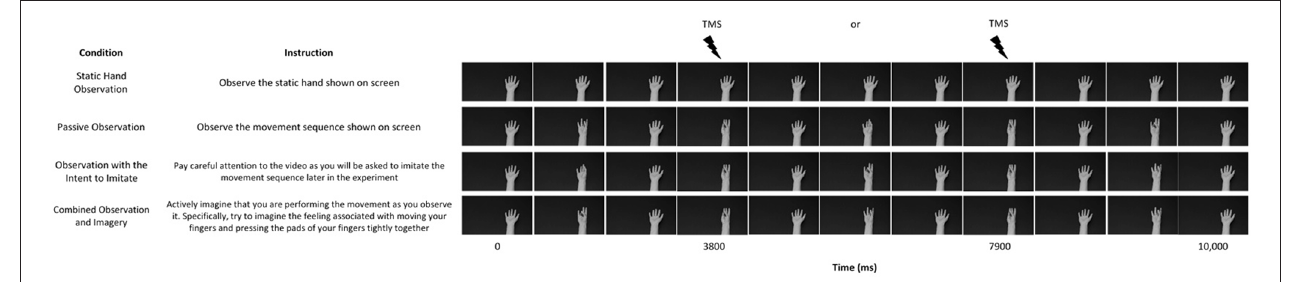
FIGURE 1 | A schematic representation of the four conditions in the experiment. All videos were 10,000 ms duration and one stimulation was delivered per trial at either 3800 or 7900 ms.